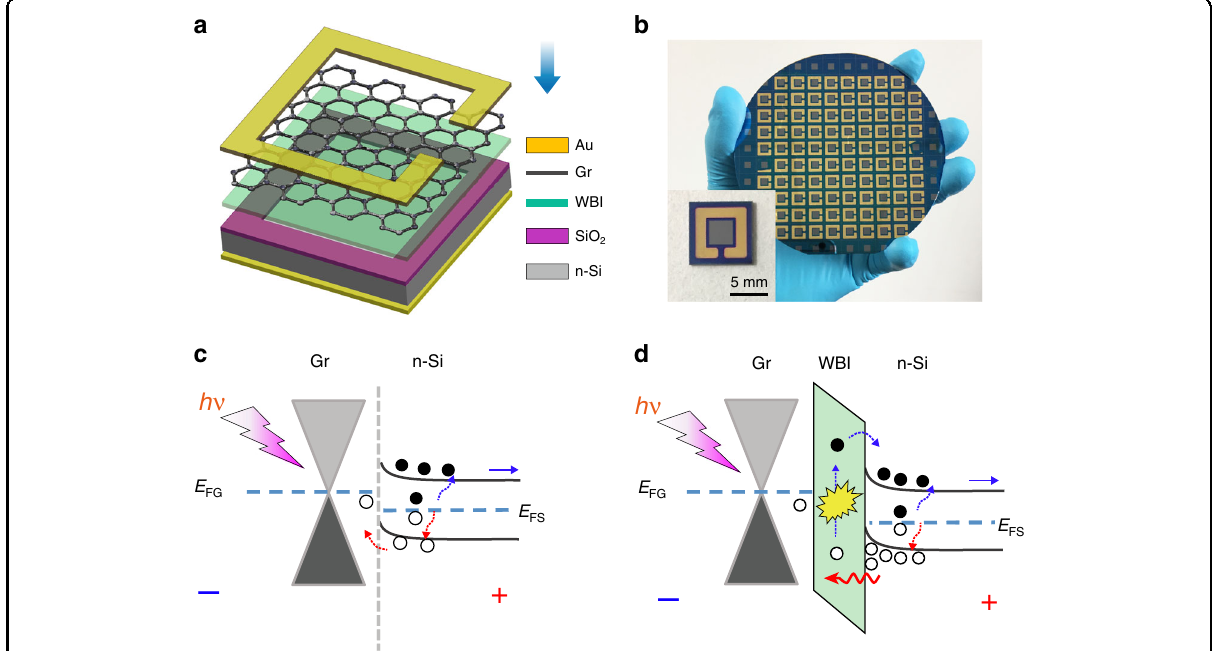
Fig. 1 Device structure and proposed working mechanism for the devices. a Schematic and b photo image of the fabricated wafer-scale graphene/insulator/Si (GIS) heterojunction photodetectors. The device size was 8 × 8 mm 2 with a center active region of 3 × 3 mm 2 . c , d Shows the corresponding energy band diagram of the conventional GS heterojunction photodetector and the GIS heterojunction photodetector under reverse bias and illumination,